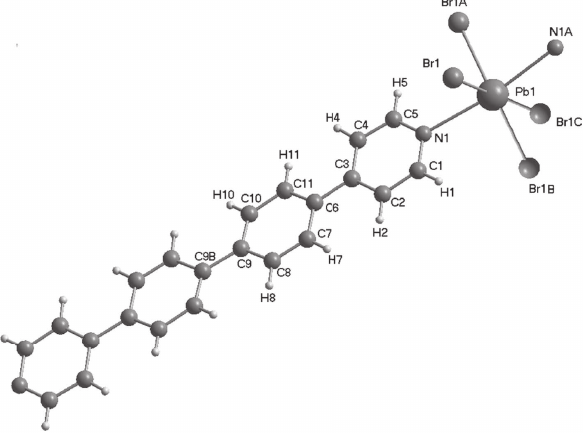
Table 1: Data collection and handling.